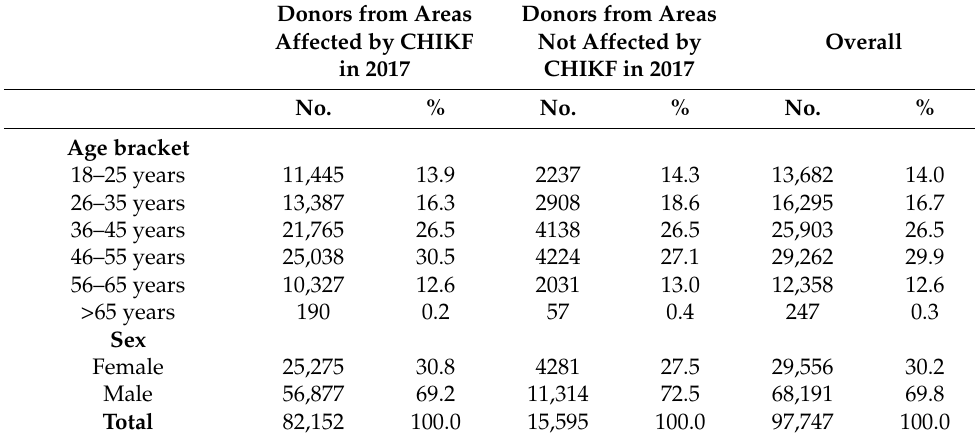
Table 1. Demographic characteristics of the populations of blood donors from the Blood Establish- ments in the areas included in the study in the year 2017. Donors from Areas Donors from Areas Affected by CHIKF Not Affected in 2017